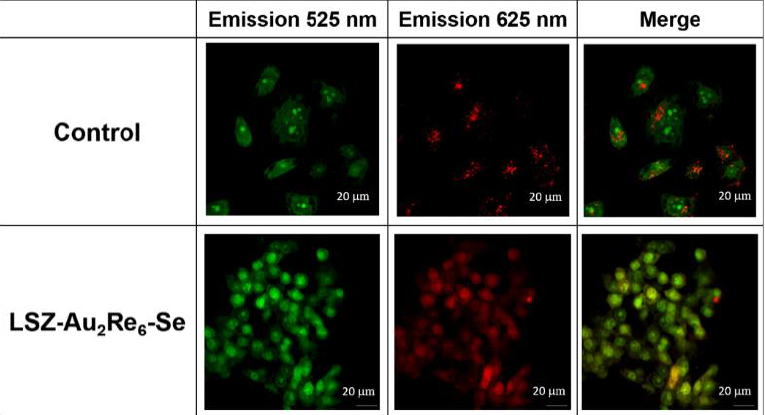
Figure 5. CLSM images showing the rapture of endo/lysosomal membranes in M-HeLa cells incu- bated by LSZ-Au 2 Re 6 -Se through the AO assay. Cells treated with Acridine Orange only were used as control.